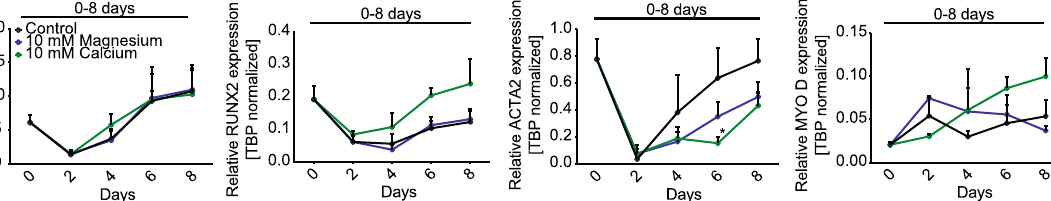
Phosphorylation of C/EBP β is primarily mediated through ERK. We observed hyperactivation of ERK upon high extracellular calcium treatment from 6–48 hours, with strongest effects after six hours (Fig. 2B, S2B) and throughout the eight-day time course of differentiation (Fig. 2C, S2C). Interestingly, reducing extracellular cal- cium decreased ERK phosphorylation throughout the eight-day time course of differentiation, indicating that lower levels of ERK phosphorylation associate with elevated adipocyte differentiation in this experimental setup. In contrast, phosphorylation of Akt, was not significantly altered upon high calcium exposure (Fig. 2B). Regulation of ERK signaling through extracellular calcium via the calcium sensing receptor (CaSR) is very unlikely as its expression is not detectable in our cells, regardless of treatment (Figure S2D). Thus, we hypothesized that raising extracellular calcium could activate the calcium/calmodulin-dependent serine/threonine protein